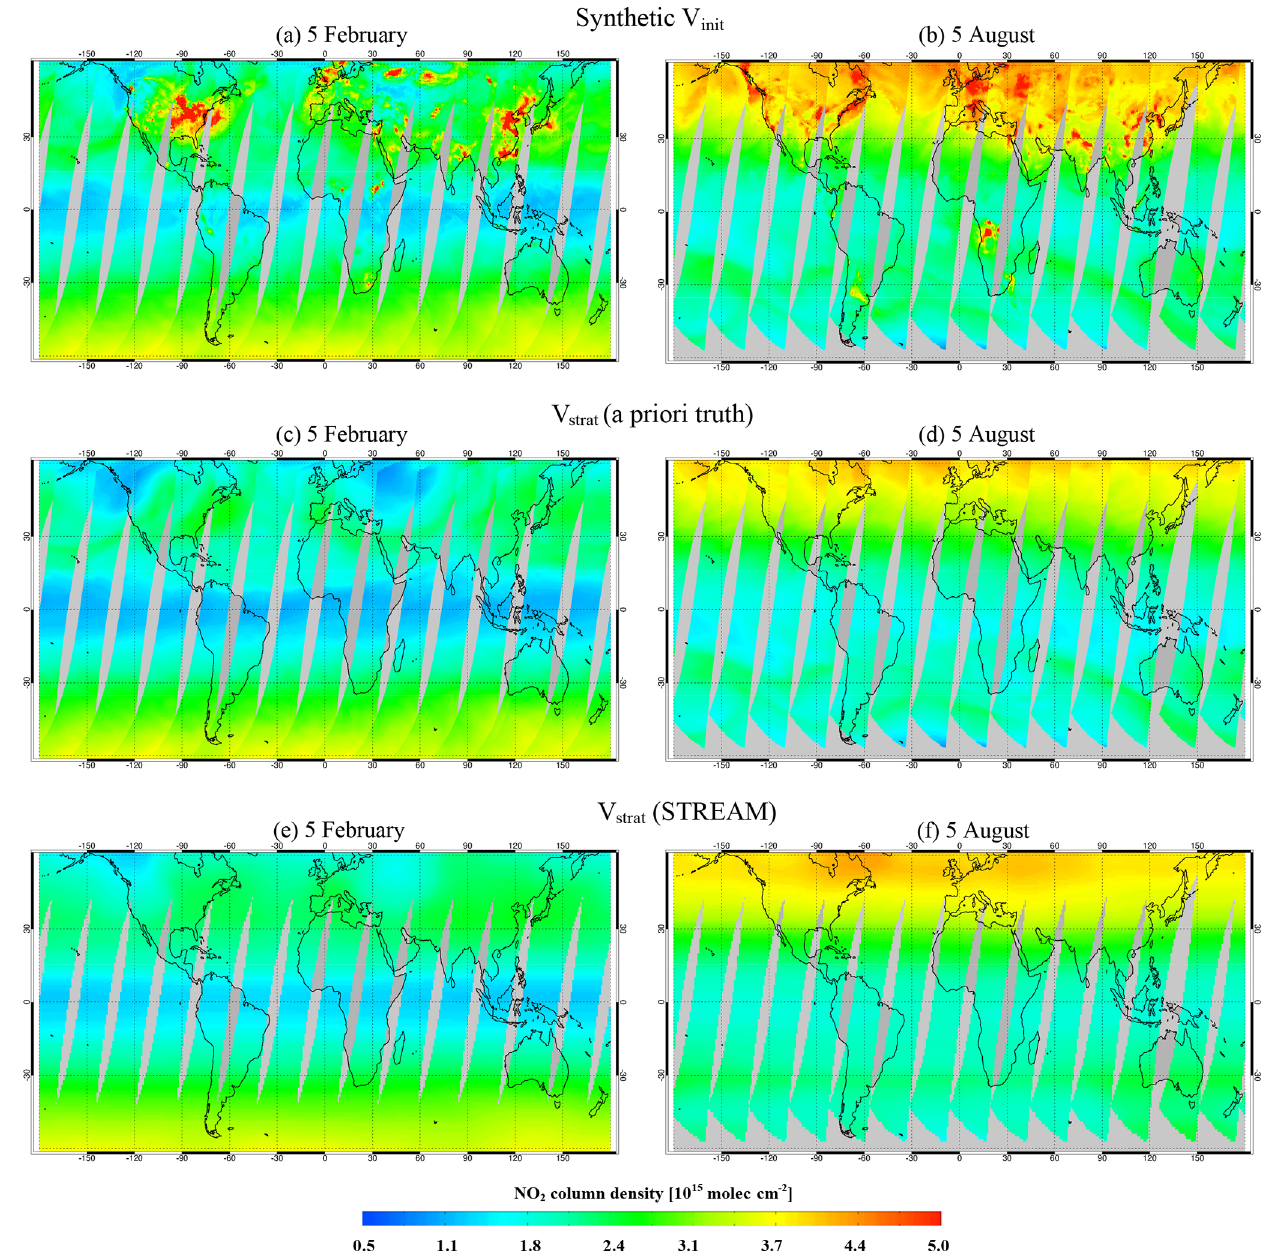
Figure 7. Synthetic initial total NO 2 columns (a, b) , a priori stratospheric columns from C-IFS (c, d) , and estimated stratospheric columns from STREAM (e, f) on 5 February (a, c, e) and 5 August (b, d, f) 2009.